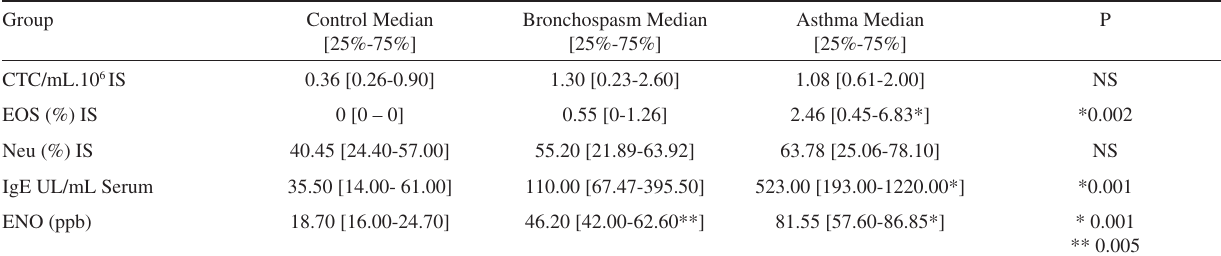
Table 2 - Inflammatory markers (median [25%-75%]) Group Control Median [25%-75%]